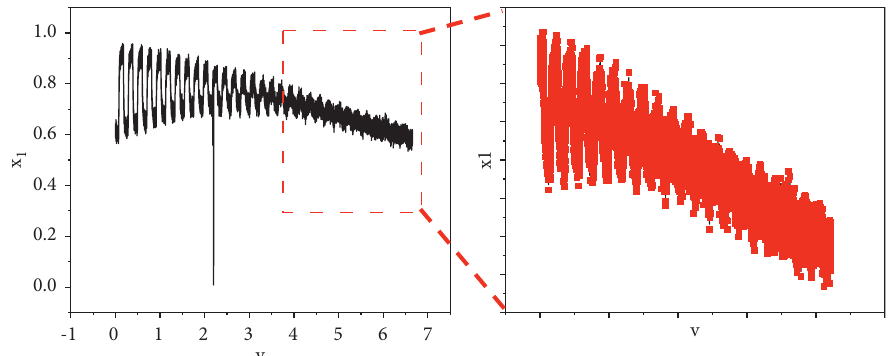
Figure 3: One-parameter bifurcation diagram of the system with respect to v for fixed parameters.